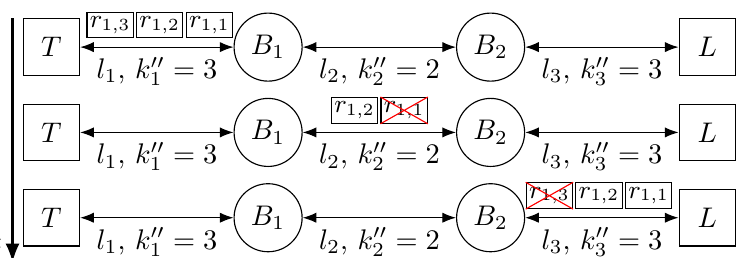
Figure 7. Behaviour of the approach C of the PTRF mechanism in the presence of temporary faults in the links.